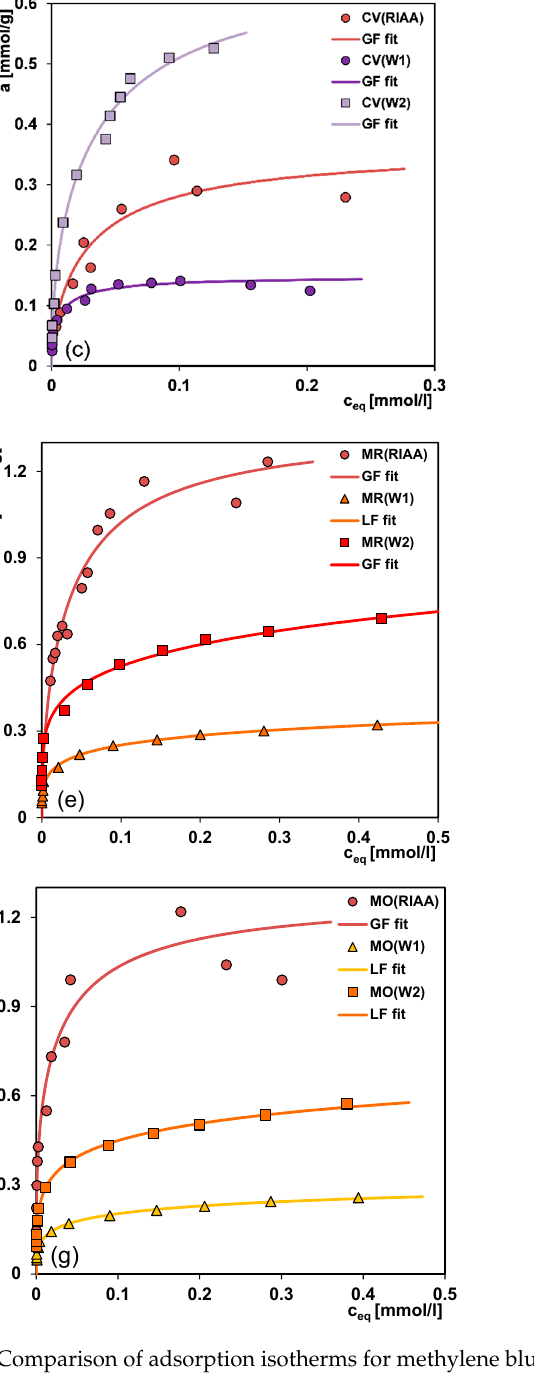
Figure 7. Comparison of adsorption isotherms for methylene blue ( a , b ); crystal violet ( c , d ); methyl red ( e , f ); methyl orange ( g , h ) on the studied activated carbons in the standard and reduced coordinate systems.